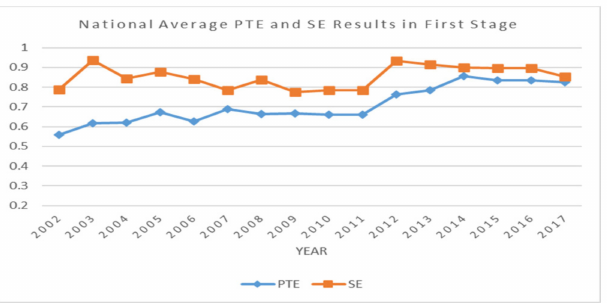
Figure 2. National average of pure technical efficiency (PTE) and scale efficiency (SE) over the study period in the first stage.